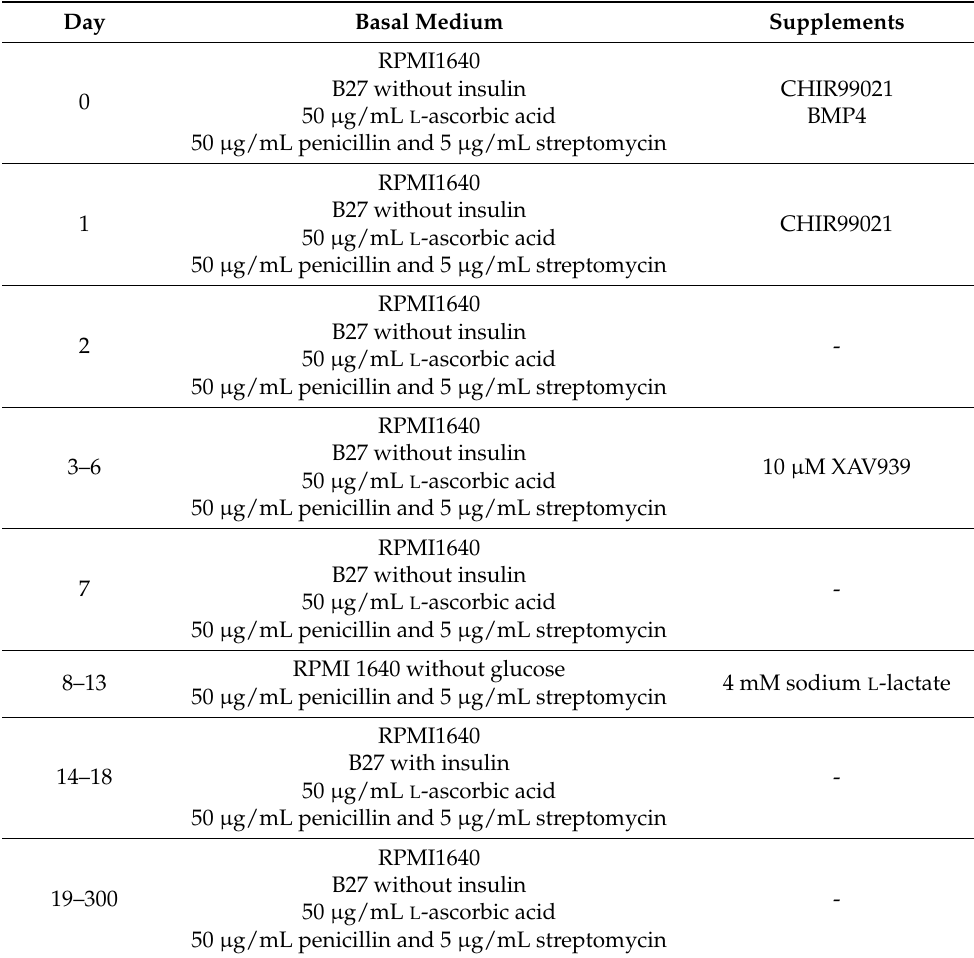
Table 1. Media composition and layout of the differentiation protocol to generate hPSC-CMC, according to [21] with